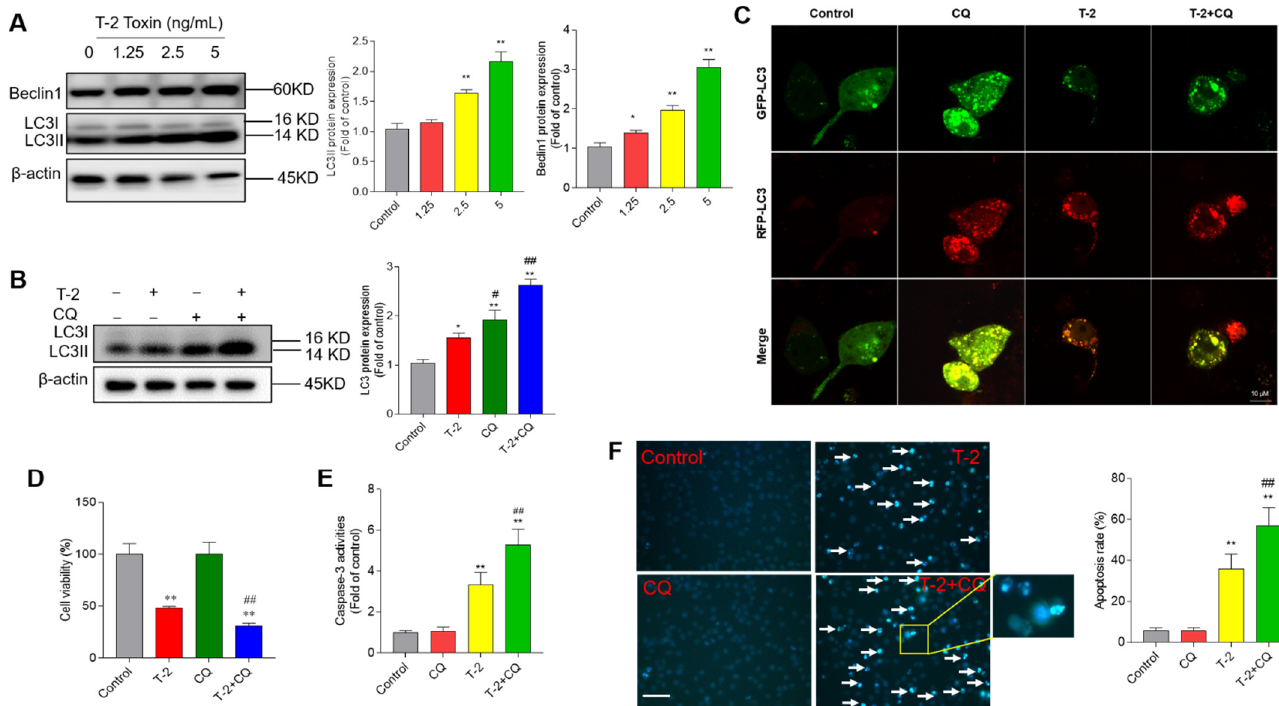
Figure 7. T-2 toxin treatment activates cell autophagy and autophagy play a protective role. ( A ) BV2 cells were treated with T-2 toxin at 1.25, 2.5, and 5 ng/mL for 24 h; the expressions of Beclin1 and LC3II proteins were measured by Western blot. The representative bands (on the left) and quantitative analysis (on the right) are shown. ( B ) BV2 cells were pre-treated with chloroquine (CQ) at 5 μM for 1 h, then co-treated with T-2 toxin at 2.5 ng/mL for an additional 24 h; the expression of LC3II protein was measured. ( C ) Autophagy flux was monitored by the mRFP-GFP-LC3 plasmid transfection method. Cells were treated with Q at 5 μM, T-2 toxin at 2.5 ng/mL, or co-treatment for 12 h; autophagosomes and autolysosomes were observed and photographed by a laser scanning confocal microscope. Bar = 10 μm. ( D – F ) Same treatments in BV2 cells as in B; cell viabilities ( D ), caspase-3 activities ( E ), and cell apoptotic rates ( F ) were measured. The results are shown as the means ± SD from three independent experiments ( n = 3). * p < 0.05 and ** p < 0.01, compared to the control; # p < 0.05, and ## p < 0.01, compared to the T-2 alone treatment